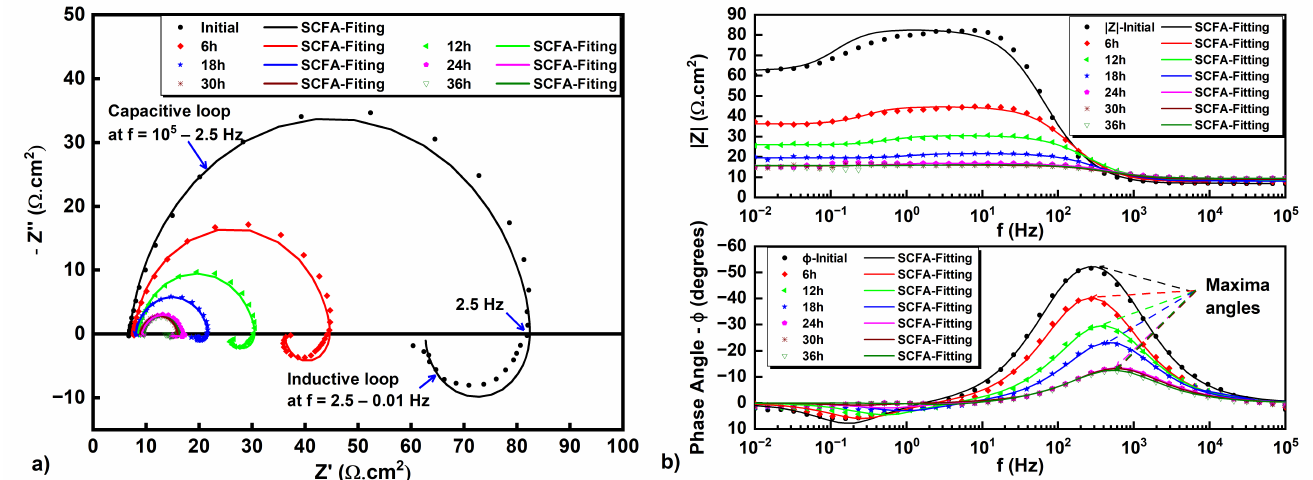
Figure 9. Electrochemical impedance spectrum for the untreated, non-nitrided FeAl40 alloy in 0.25 M H 2 SO 4 solution at 25 ◦ C at the initial time and as a function of immersion time: ( a ) Nyquist plot; ( b ) Bode